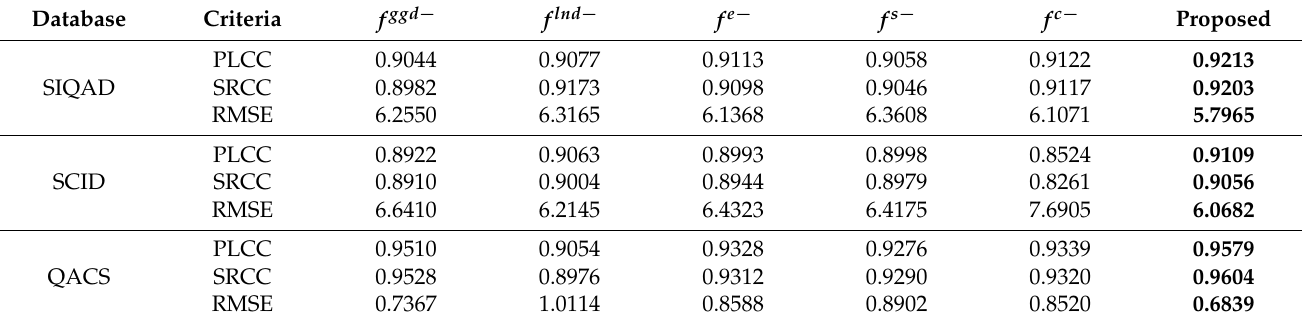
Table 4. Performance results of different features of the proposed method on the SIQAD, SCID and QACS databases.